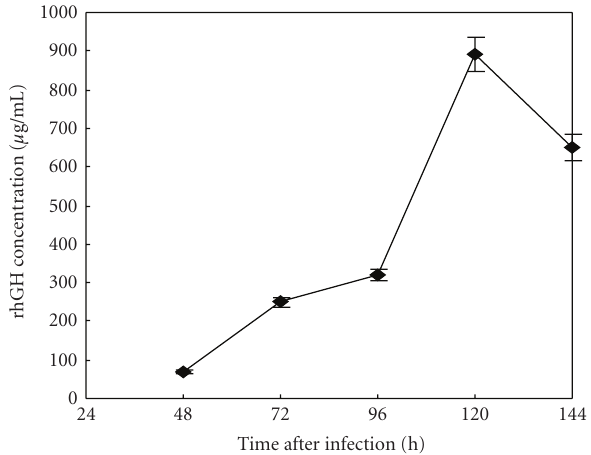
Figure 2: Time course of the BmrhGH expression in silkworm pupae. Pupae were collected each day from 48 hours postinfection and protein samples were prepared by centrifuging at the speed of 1,5000 g. BmrhGH in silkworm pupae extracts was determined by ELISA. Each value represents the mean of triplicate